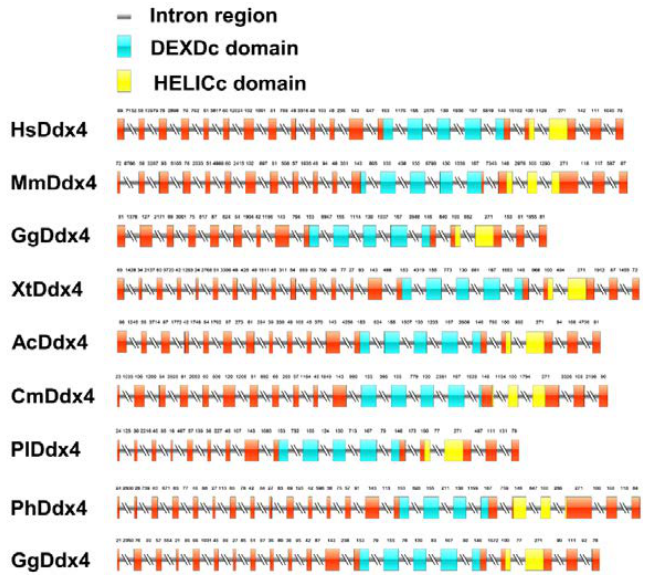
Figure 2. Schematic genomic structure of vasa genes between leopard coral grouper ( Plectropomus leopardus ) and other vertebrates. Red, blue and yellow rectangles represent exons: blue blocks indicate the DEXDc domain and yellow blocks indicate the HELICc domain. Rectangles with double slash represent introns. DEXDc, DEAD-like helicases superfamily; HELICc, helicase superfamily C-terminal.